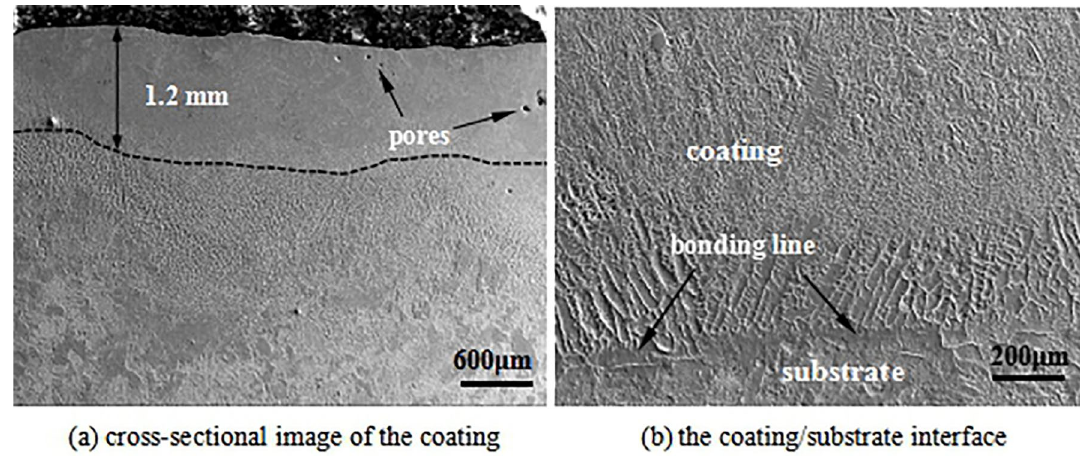
Figure 3. Cross-sectional images of the composite coatings.